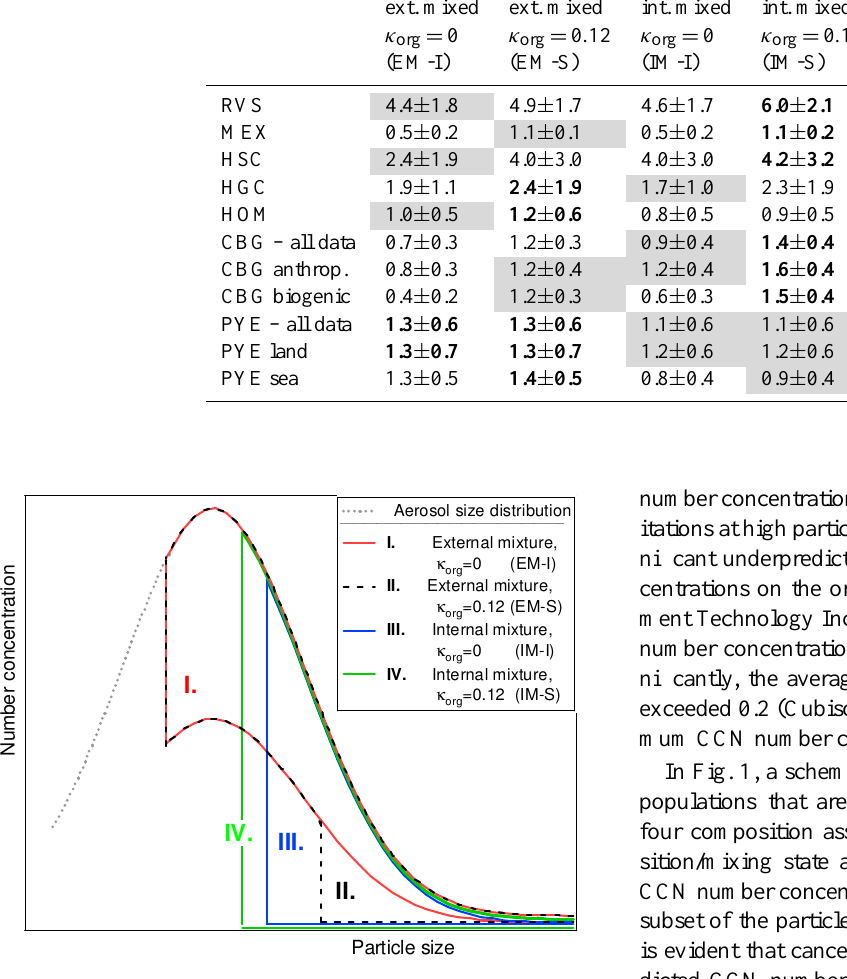
Fig. 1. Schematic of areas of activated number concentrations for different composition/mixing state